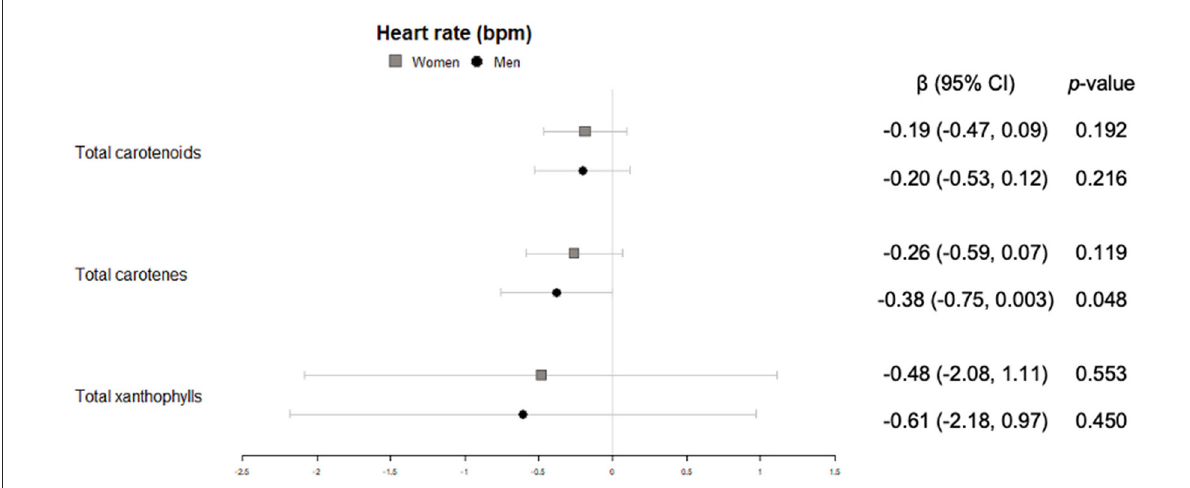
FIGURE3 Cross-sectional association of plasma carotenoids and subclasses (per unit increase) with heart rate (bpm) (95%-CI), and their respective p -values.